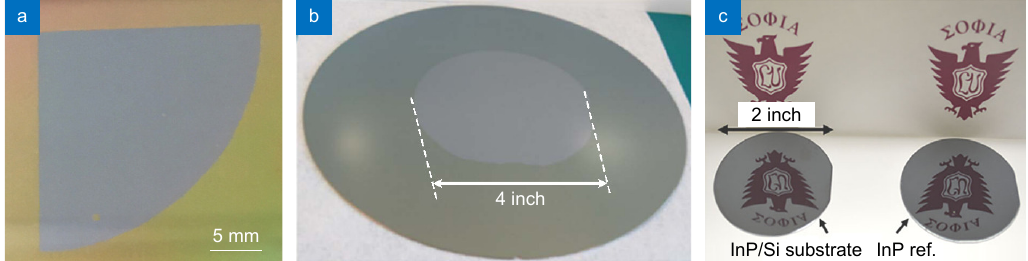
Fig. 2 | Pictures of the fabricated InP-on-Si bonded wafers from HPE, III-V Lab and Sophia University. Figure repoduced with permisson from: (a) ref. 29 , under a Creative Commons Attribution 4.0 International License; (b) ref. 31 , (c) ref. 25 , John Wiley and